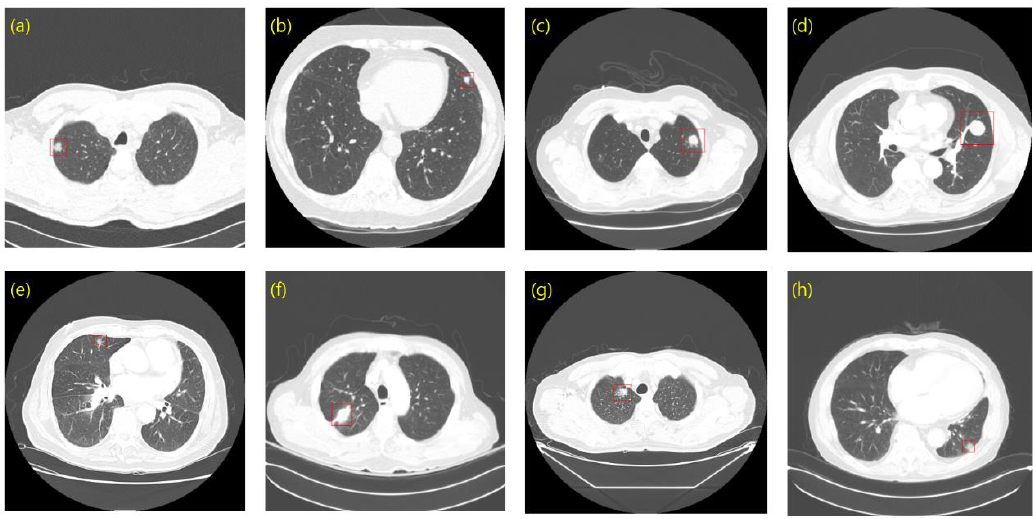
Figure 1. Ground truth sample. ( a – d ) LUNA16; ( e – h ) Private data.